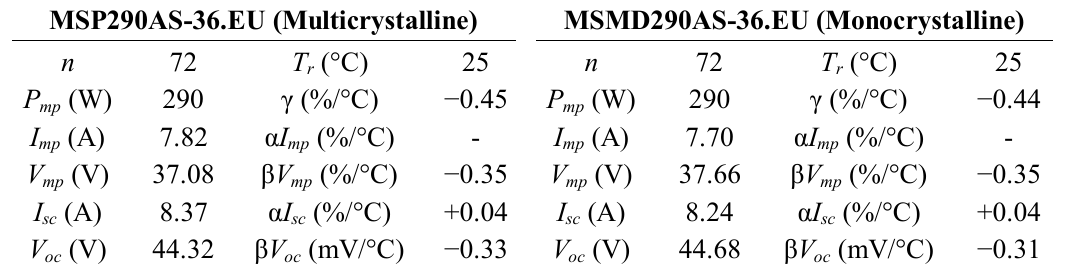
Table 3. Characteristic points of MSP290AS-36.EU and MSMD290AS-36 solar panels (München Solarenergie GmbH), included in the manufacturer datasheets [52,53] at STC (Standard Test Conditions) (1000 W/m 2 irradiance, 25 °C cell temperature, AM1.5g spectrum according to EN